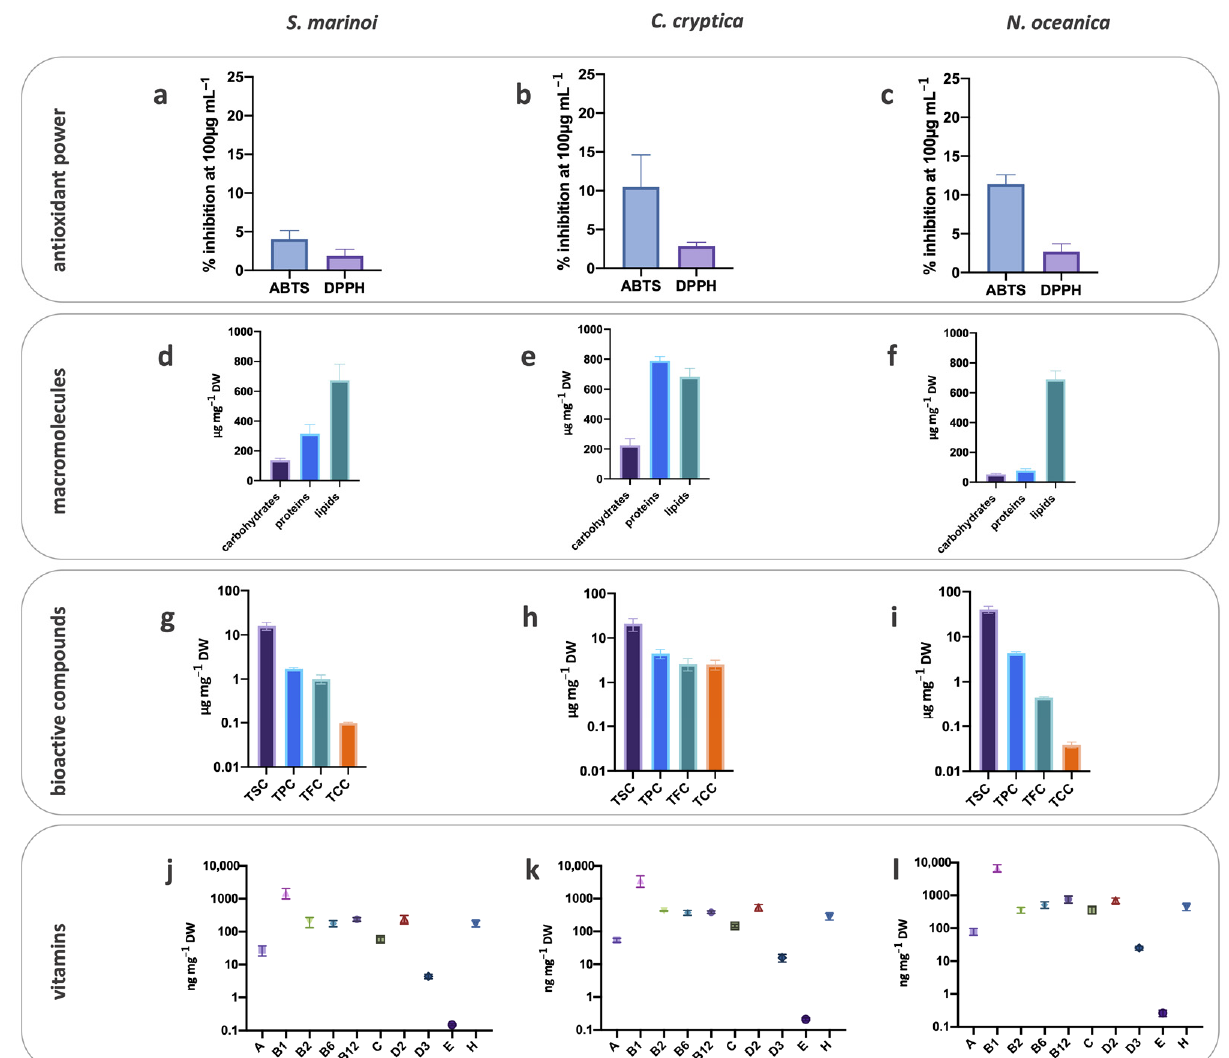
Figure 1. Antioxidant capacity (ABTS and DPPH scavenging ability) of the biomass from S.m. ( a ), C.c. ( b ) and N.o. ( c ); macromolecular composition of the biomass from S.m. ( d ), C.c. ( e ) and N.o. ( f ); bioactive compounds content of the biomass from S.m. ( g ), C.c. ( h ) and N.o. ( i ) and vitamin content of the biomass from S.m. ( j ), C.c. ( k ) and N.o. ( l ) (y axis in log scale). S.m. = Skeletonema marinoi , C.c. = Cyclotella cryptica , N.o.= Nannochloropsis oceanica . TSC = total sterols content, TCC = total carotenoids content, TPC = total polyphenols content, TFC = total flavonoids content. Values are expressed as mean ± SD.